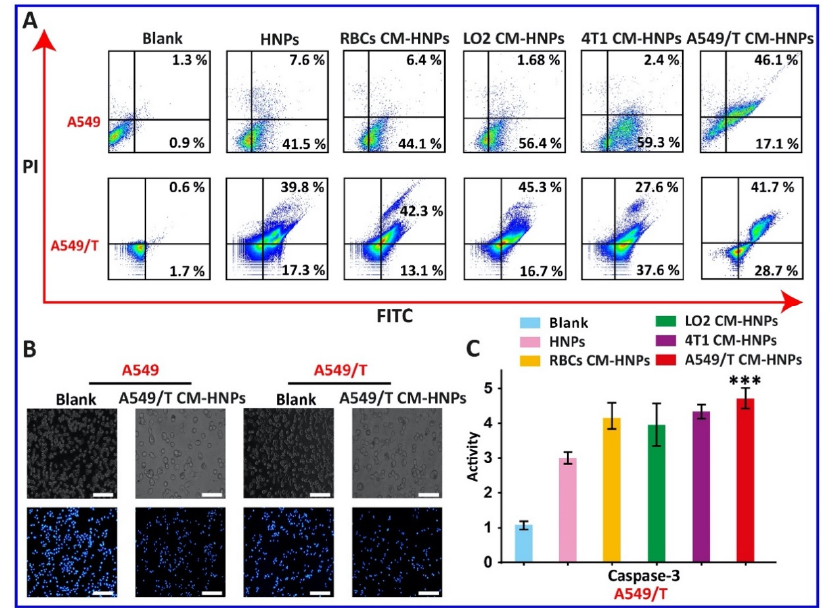
Figure 10. Apoptotic study. ( A ) Annexin V-FITC / PI apoptosis assay in A549 and A549 / T cells after treatment with CM-HNPs at a fixed PTX concentration of 5 µ g / mL for 24 h at 37 ◦ C. ( B ) Cellular and nuclear morphology of cells after treatment. Scale bar = 100 µ m. ( C ) Caspase-3 activity of A549 / T cells after treatment with CM-HNPs for 24 h at 37 ◦ C; n = 3, one-way ANOVA and Tukey analysis applied, and level of significance was *** p < 0.001 vs.